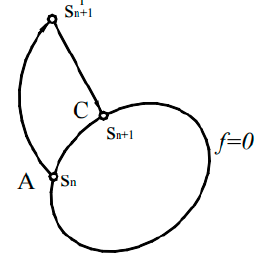
Figure 13. Sketch of the radial return method.